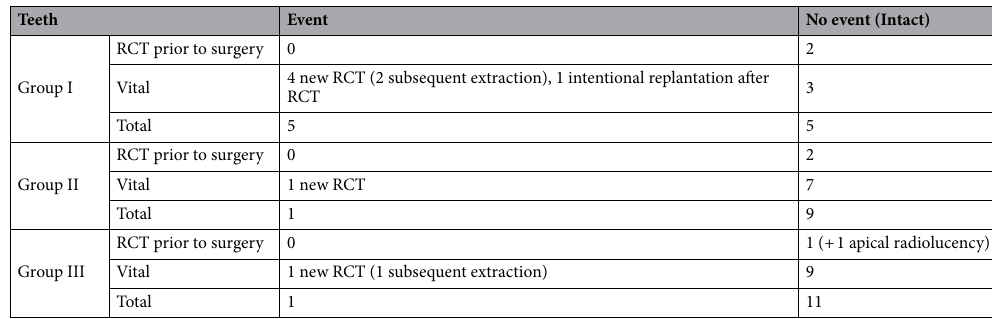
Table 3. Complication frequency according to the group. RCT (root canal treatment), Prior RCT (RCT prior to implant surgery), New RCT (RCT after surgery due to apical lesion or symptoms